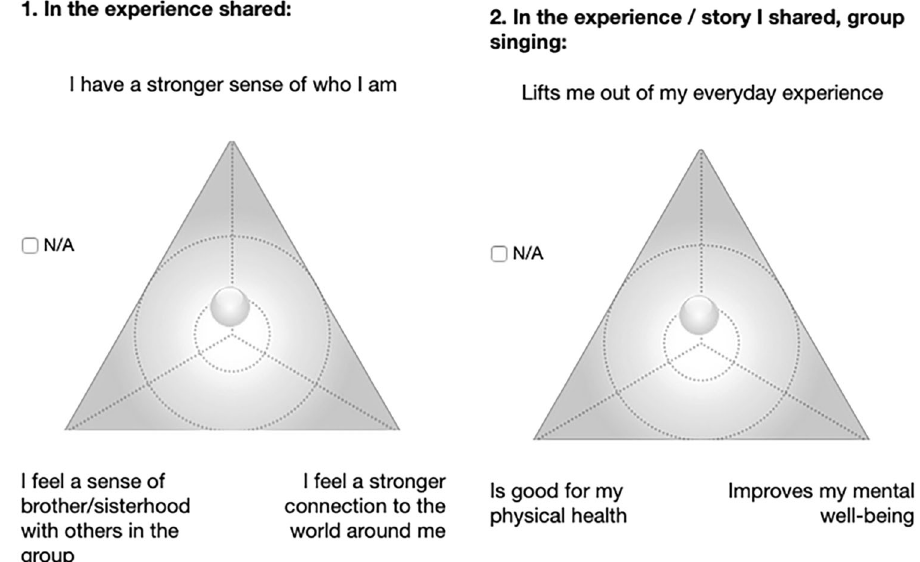
Fig. 1 Sensemaker ® signi fi cation interface.